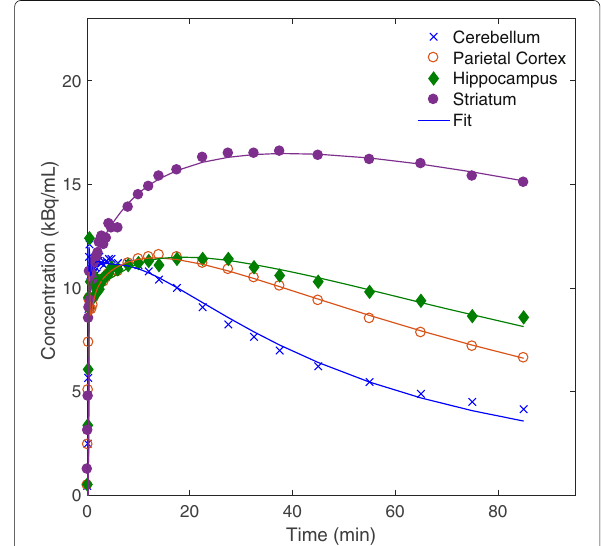
Fig. 3 TACs from one subject with simultaneously fitted curves using SIME constrained